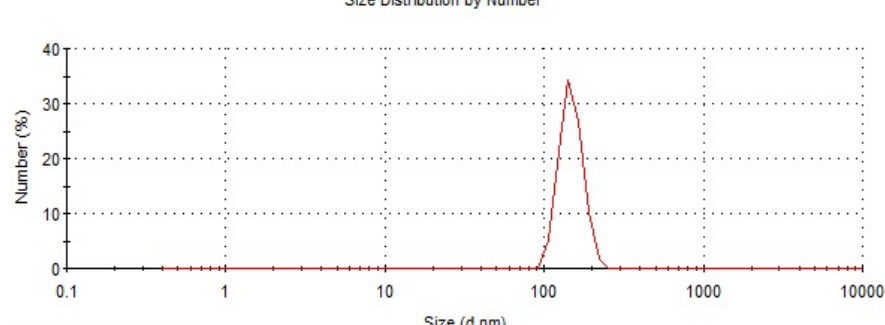
Fig. 4. Dynamic light scattering analysis of CHX-CS